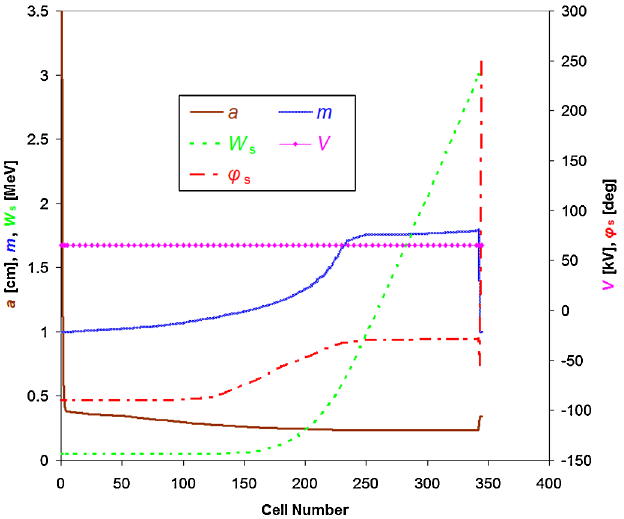
FIG. 4. (Color) Main dynamics parameters along the RFQ.